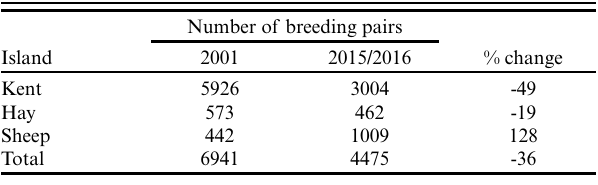
Table 3 . Estimates of Herring Gull ( Larus argentatus ) colony size at the Three Islands Group in the Bay of Fundy, Canada, and percentage change between 2001 and